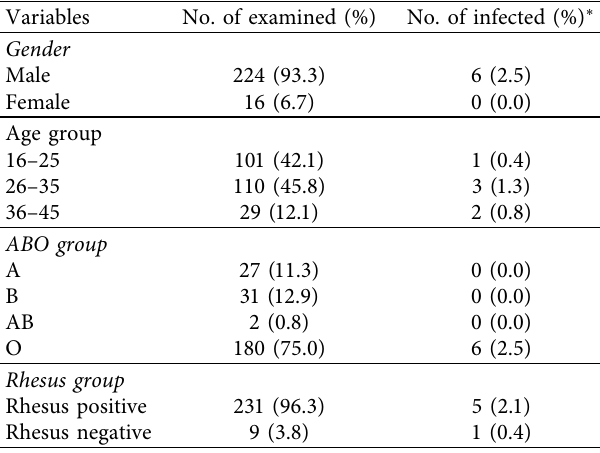
Table 1: Distribution of malaria parasite infection among blood donors.